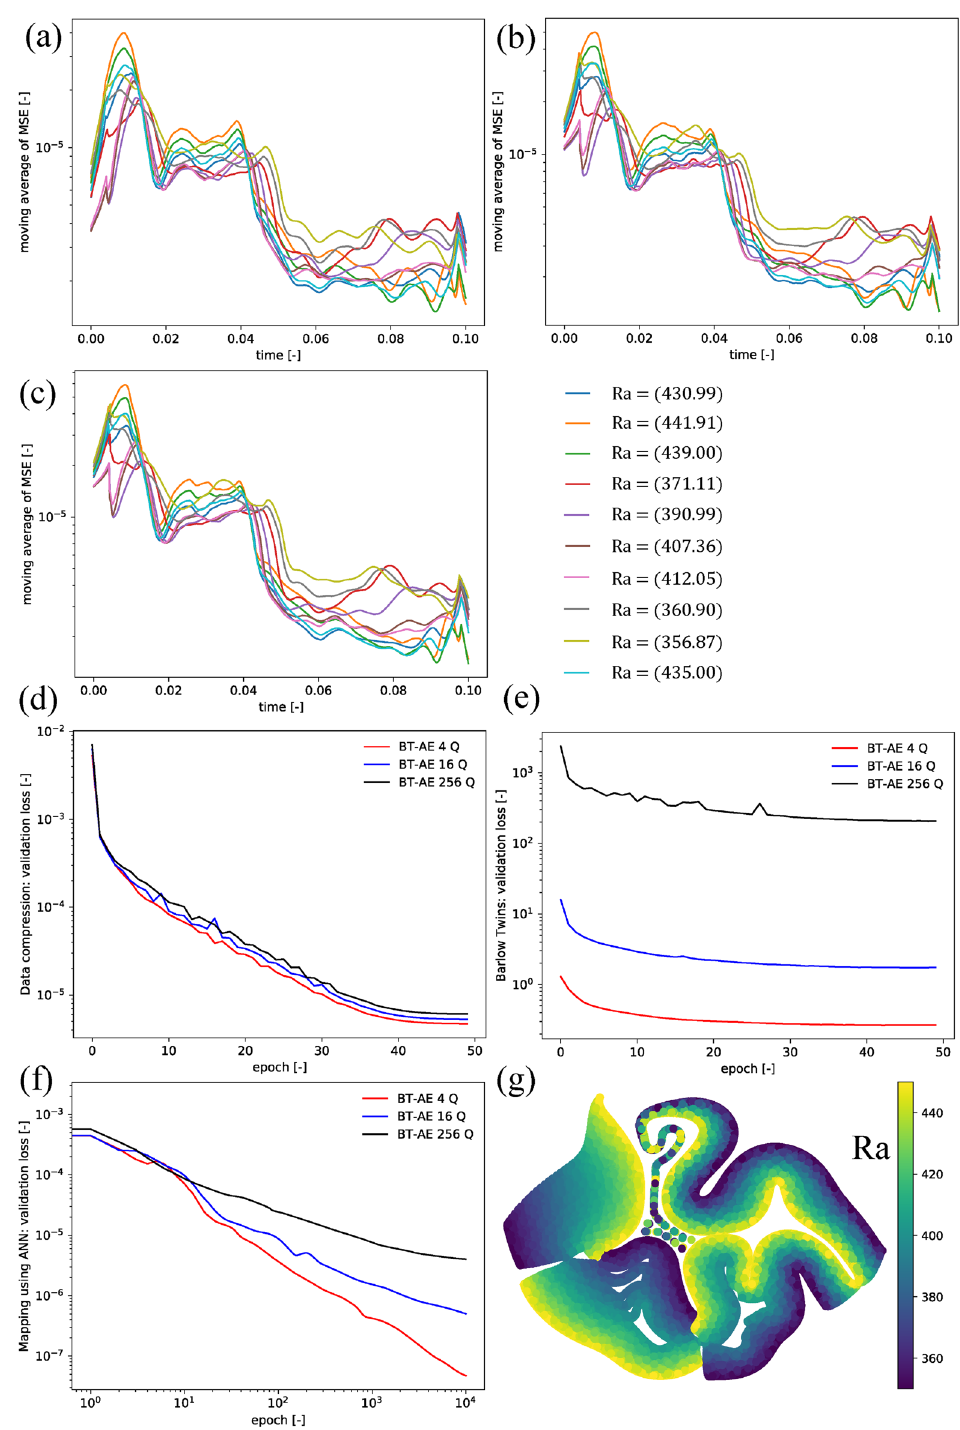
Figure 4. Example 3 results: the moving average (a window size of 50) of mean squared error (MSE) of ( a ) BT– AE 4 Q, ( b ) BT–AE 16 Q, ( c ) BT–AE 256 Q (please refer to Table 2). ( d ) Data compression loss for validation set (Eq. 18), ( e ) Barlow Twins loss for validation set (Eq. 14), ( f ) mapping using ANN loss for validation set (Eq. 19), and ( g ) latent space plot of BT–AE 16 Q model. Latent space plots are constructed using t-Distributed Stochastic Neighbor Embedding (t-SNE). Different colors represent each value of Ra value. We calculate the t-SNE plots using Scikit-Learn package using its default setting and perplexity of